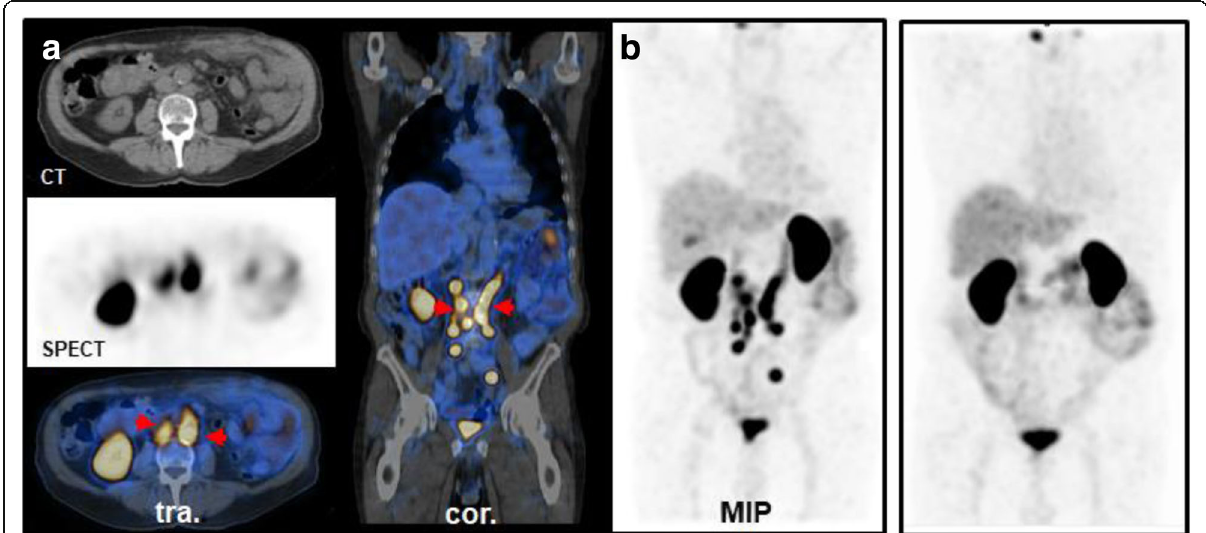
Fig. 6 [ 99m Tc]Tc-PSMA-I&S-SPECT/CT of a 71-year-old patient with mCRPC and disease progression and severe fatigue after the second cycle of chemotherapy (docetaxel). a Pretherapeutic tumor spread in paraaortic and pelvic lymph nodes (PSA 335 ng/ml). b Restaging 3 months after 2